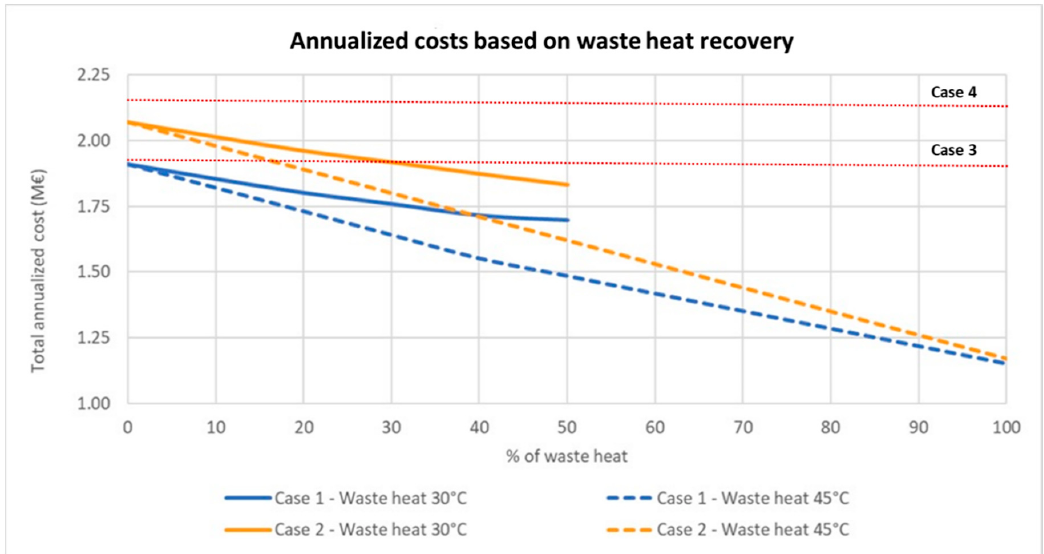
Figure 13. Total annualized cost as a function of the share of total heat demand recovered from waste heat sources.